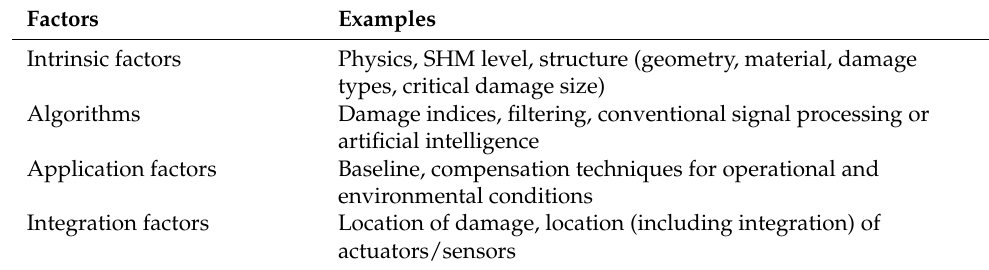
Table 1. Factors influencing the quality, capability and reliability of an SHM system.